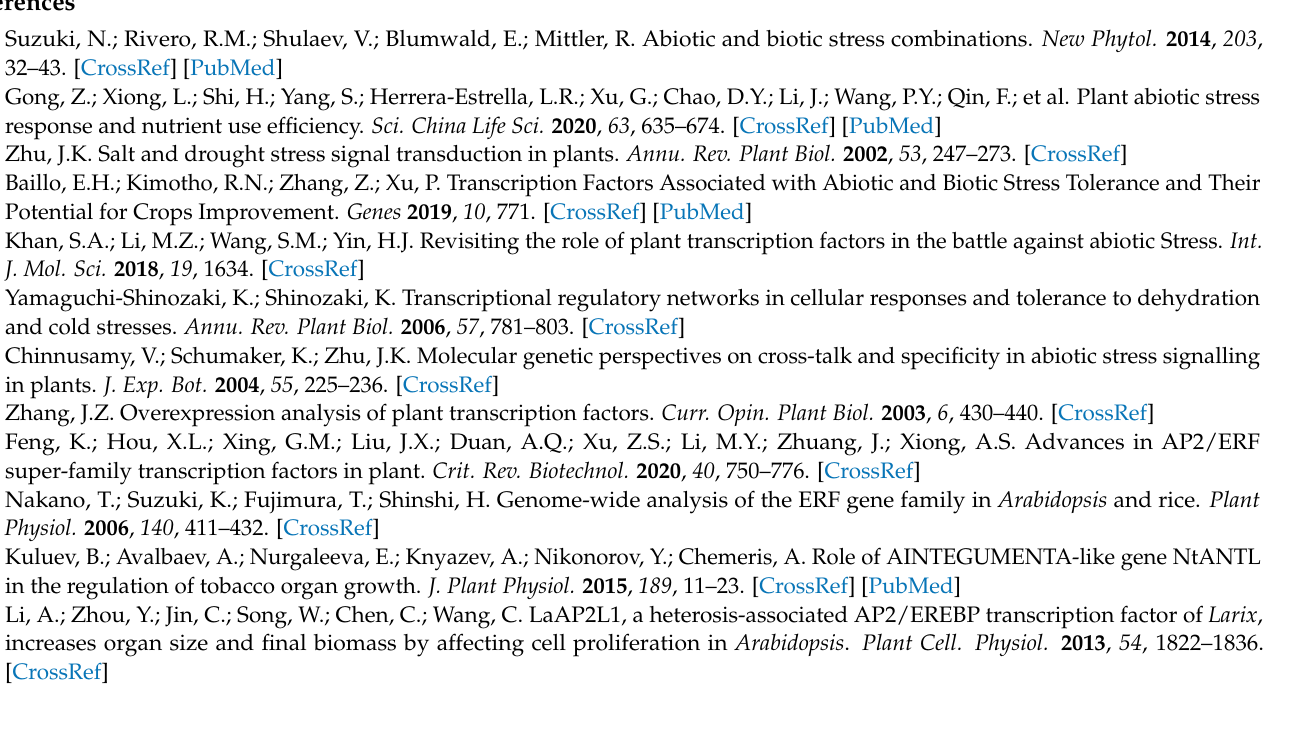
Table S1: List of XsAP2/ERF genes identified, Table S2: Gene duplication analysis of XsAP2/ERF genes, Table S3: q-PCR